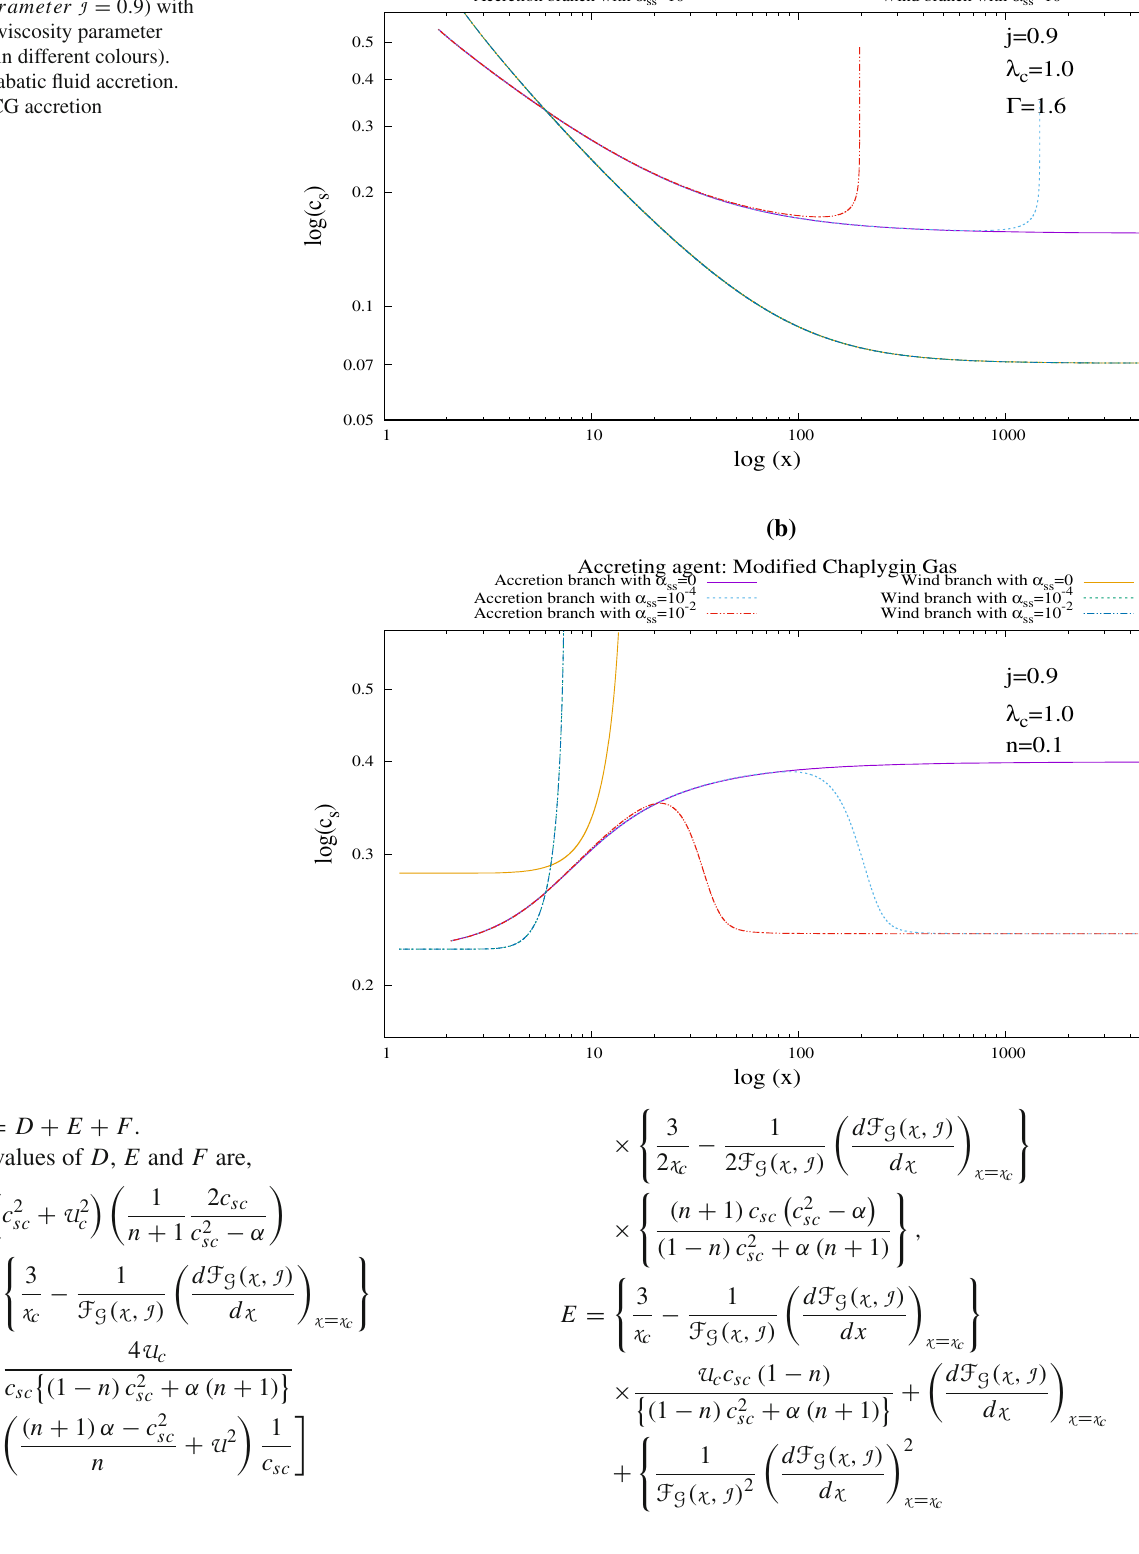
Fig. 3 Plots of accretion and wind branches for log ( c s ) (log of sound speed) vs log ( x ) for rotating black hole ( spin parameter J = 0 . 9) with different viscosity parameter (showed in different